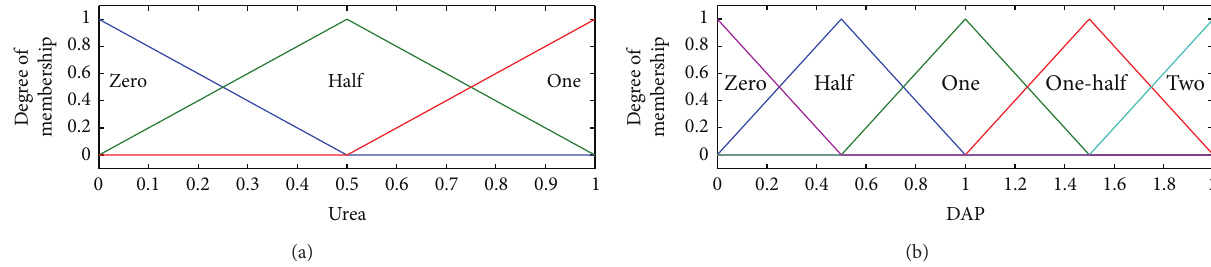
Figure 6: Membership functions for urea and DAP.